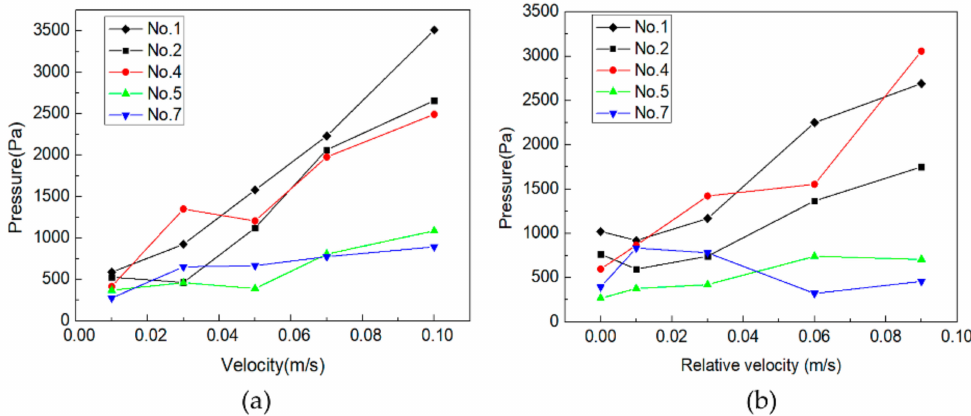
Figure 10. Simulation results of cell surfaces suffer pressure: ( a ) relation of cell surfaces pressure with culture solution inlet velocity when microdroplet relative velocity is 0; ( b ) relation of cell surfaces pressure with the relative velocity of microdroplet when culture solution inlet velocity is 0.01